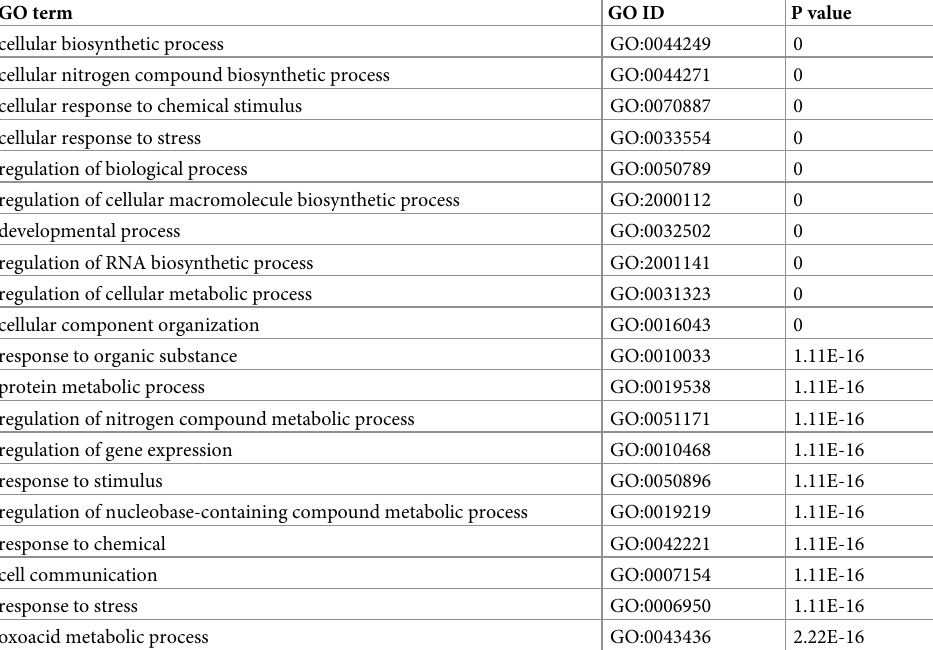
Table 4. Top 20 GO enrichment results of biological